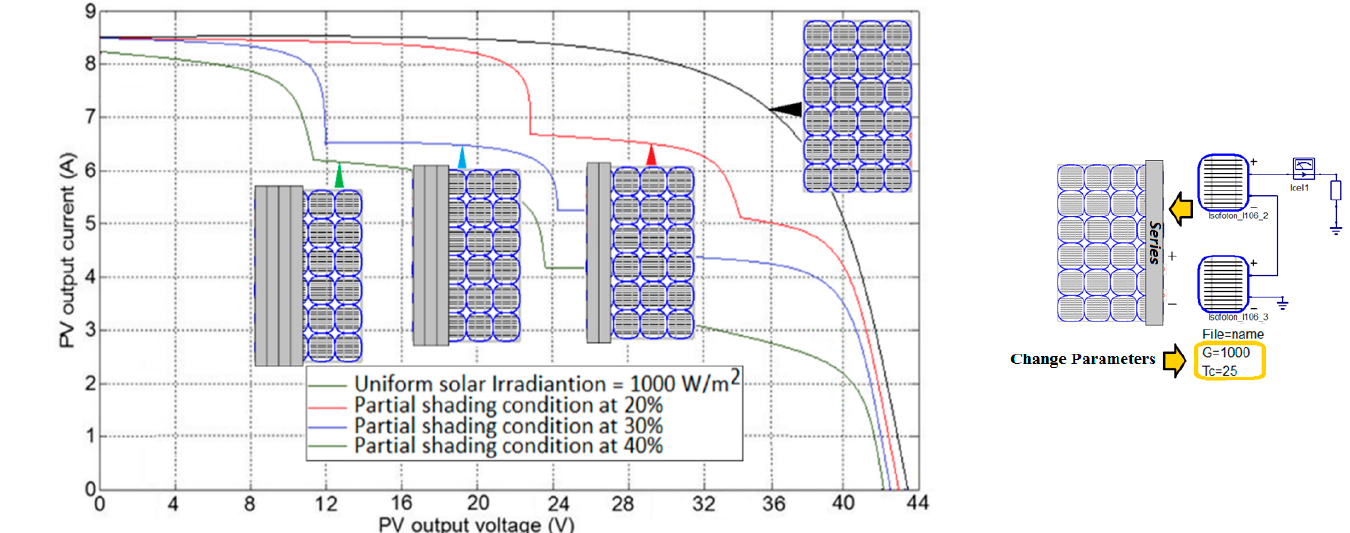
Figure 9. Current-Voltage characteristics under different partial shading conditions for series approach.